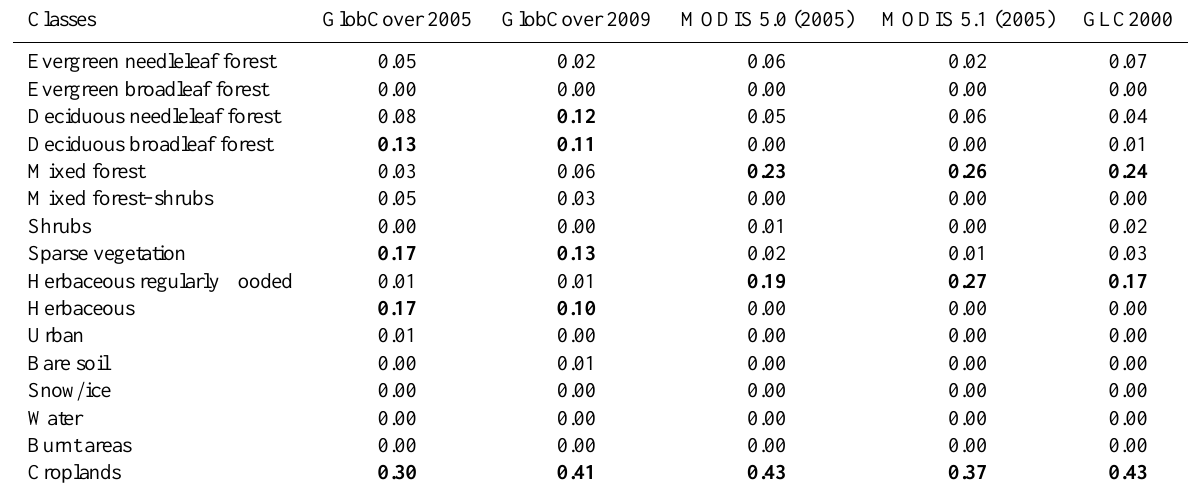
Table 6. Fraction of each class in each product for South Siberia, values larger than 0.1 appear in bold. Classes